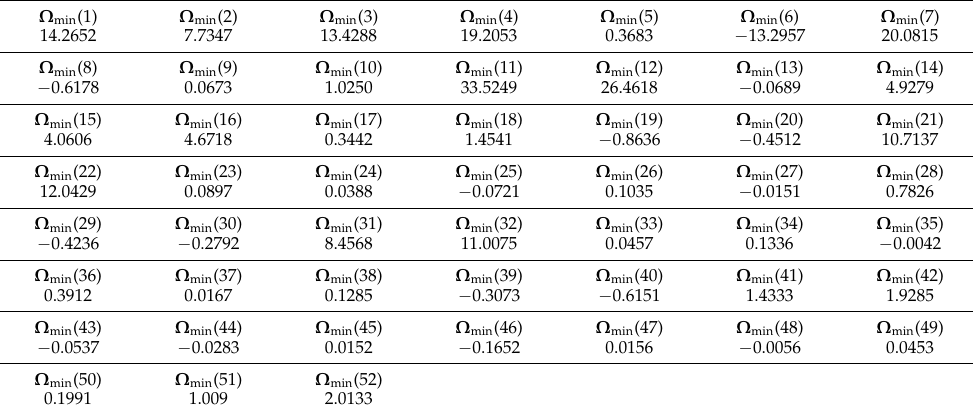
Table A1. Elements of the calculated minimum identification set Ω min